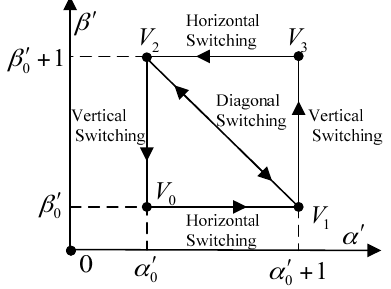
Figure 2. Locus of three basic switching modes.